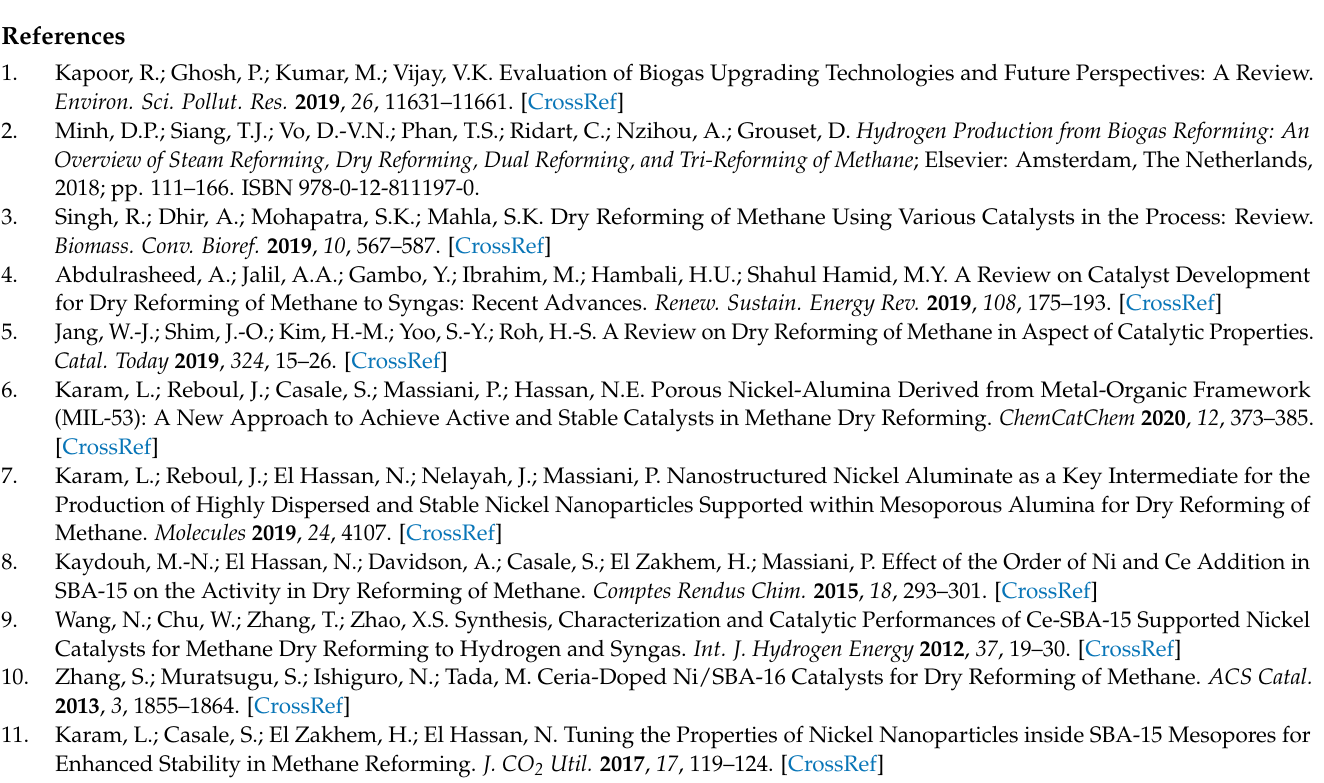
TEM micrographs; Figure S3: SEM micrographs of parent zeolites; Figure S4: Histograms of reduced catalysts; Figure S5: CH 4 and CO 2 conversions at 0, 200, 450, and 700 min of time-on-stream during long-term tests; Figure S6: Diffractograms of the Ni containing spent samples; Figure S7: TGA profiles of spent samples; Table S1: Relative and absolute CH 4 and CO 2 conversion losses during long-term